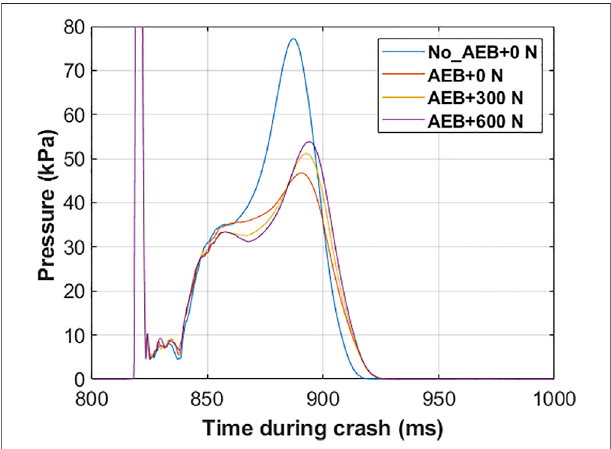
FIGURE 2 | Airbag pressures for the different simulation